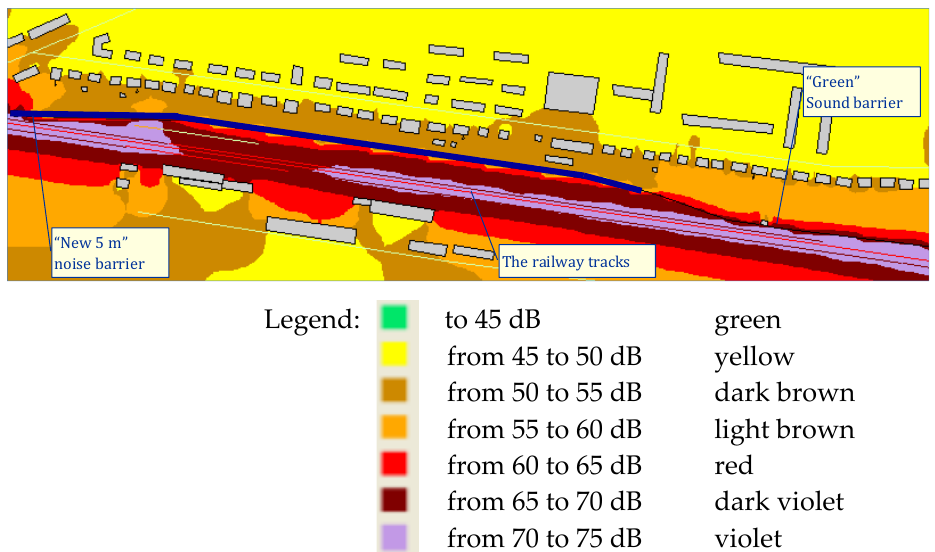
Figure 1. Noise map — the situation with the “ New 5 m ” high-noise barrier. A visualization of the noise from the railways in the Trenčín railway station; night (22:00 – 6:00 h) [18].